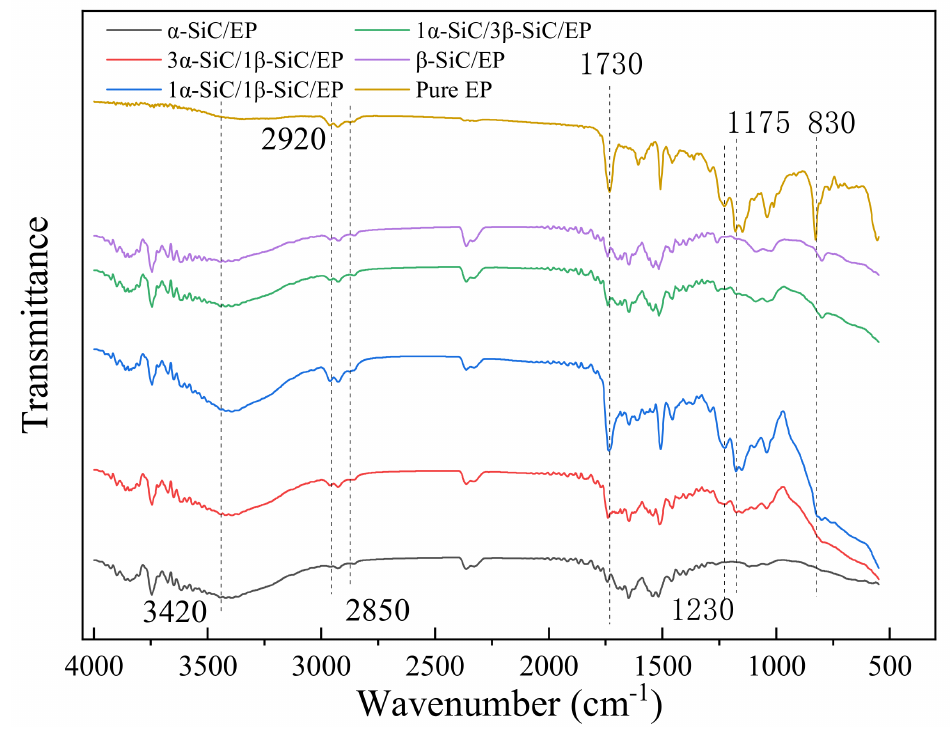
Figure 6. Infrared spectrum of SiC/EP composite